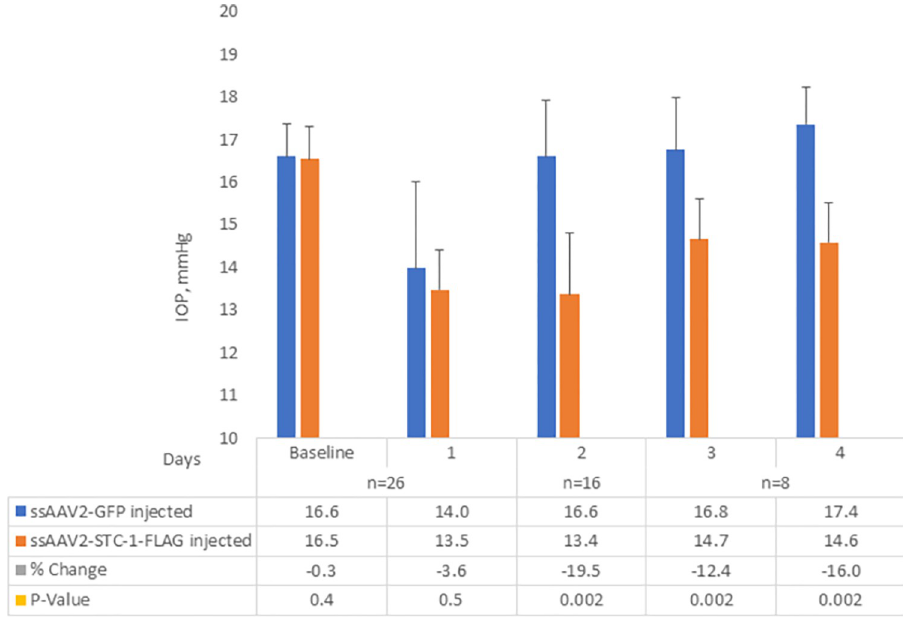
Fig 1. Early IOP lowering response following injection with ssAAV2-STC-1-FLAG. After baseline IOP measurements, three-month-old C57BL/6J mice (n = 26) received a single intracameral injection of ssAAV2-STC- 1-FLAG in one eye and ssAAV2-GFP in the fellow eye (1 μ L, intracameral injection, 3x10 9 VGs). After an initial, non- significant decrease in IOP in both ssAAV2-STC-1-FLAG treated mice and ssAAV2-GFP control mice at day 1, and a return to baseline with ssAAV2-GFP by day 2, significant IOP lowering was seen following treatment with ssAAV2-STC-1-FLAG starting at day 2. This IOP reduction persisted until the end of the experiment at day 4.